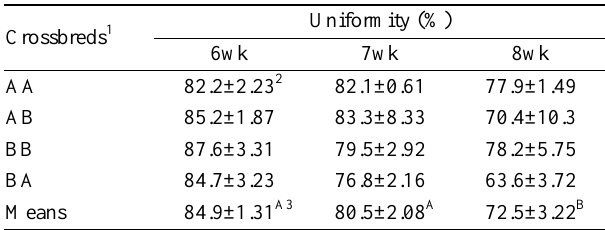
Table 4. Uniformity of commercial Korean native ducks at 6,